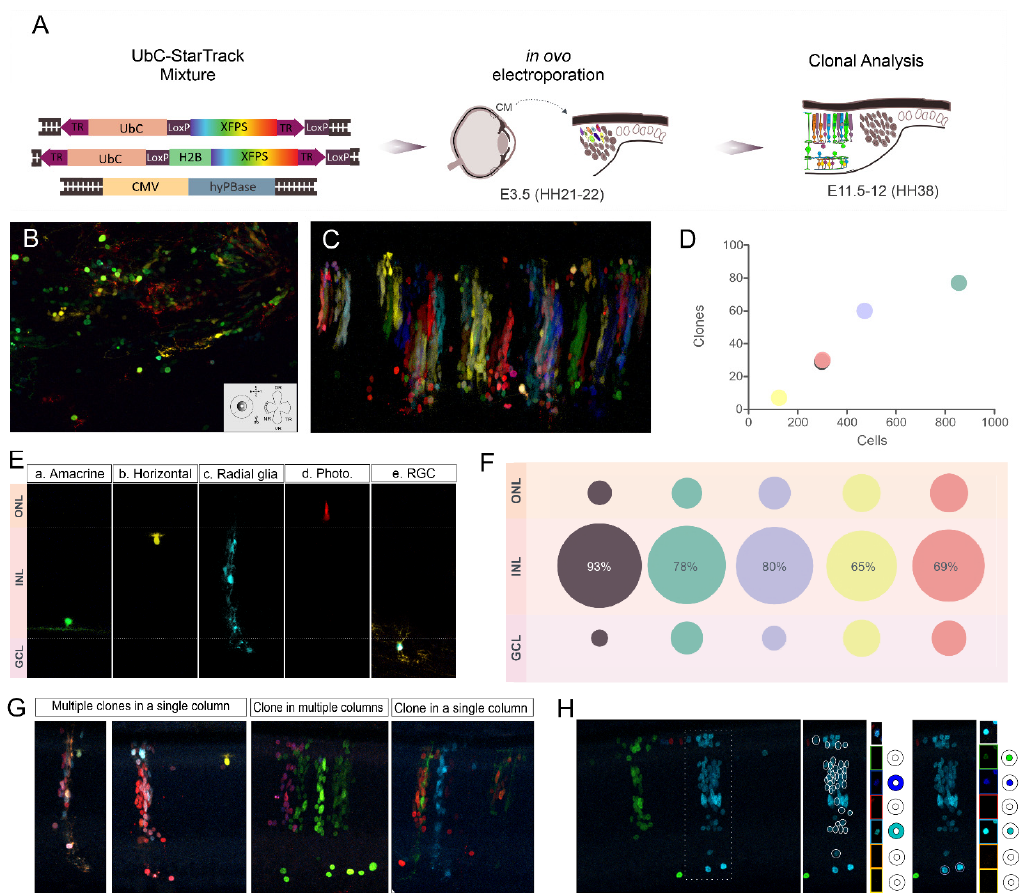
Figure 2. In ovo electroporation of the UbC-StarTrack. ( A ) General overview of IOE of UbC-StarTrack into the CM of chick embryos at E3.5 (HH21-22) and their analysis at E11.5-12 (HH38). ( B , C ) Confocal merged images of retinal whole mount ( B ) and retinal horizontal section ( C ) from chick embryos at E11.5-12 (HH38) after IOE of UbC-StarTrack at E3.5 (HH21-22). ( B ) Cell clones are observed from the external surface of the retina and individual cells are visualized from a perpendicular or oblique incidence in whole mounts. ( C ) Labeled cells observed from a longitudinal incidence, form columnar associations between the internal (basal border) and external (apical border) limits of the neural retina in horizontal sections. UbC-StarTrack labels cells in both the cytoplasm and nucleus, allowing the cells somas and processes to be seen clearly. ( D ) Graph representing the relationship between the number of clones and the number of cells detected in each of the five analyzed chick embryos. ( E ) Confocal images showing the characteristic morphology of chicken retinal cells in horizontal sections at E11.5-12 (HH38) after E3.5 (HH21-22) IOE with UbC-StarTrack. A labeled amacrine cell (a), a horizontal cell (b), a radial glia (c), a photoreceptor (cone) (d) and a retinal ganglion cell (RGC) (e) are shown. ( F ) Percentages of labeled cells located in the ONL, INL and CGL in each of the five chicken embryos analyzed. ( G ) Confocal merge images of all XFPs showing examples of sibling cells arranged in columns in the embryo retina. ( H ) Confocal image merge of all XFPs is shown on the left side. The inset shows an apparent homogenous clone in a single column. However, when analyzing the fluorescent expression at each confocal channel separately it is shown that the column is formed by two different clones: (1) a trilaminar clone formed by cells expressing mCerulean and mT-Sapphire in the cytoplasm (middle) and (2) a monolaminar (GCL) clone formed by cells expressing mCerulean, mT-Sapphire and EGFP in the nucleus